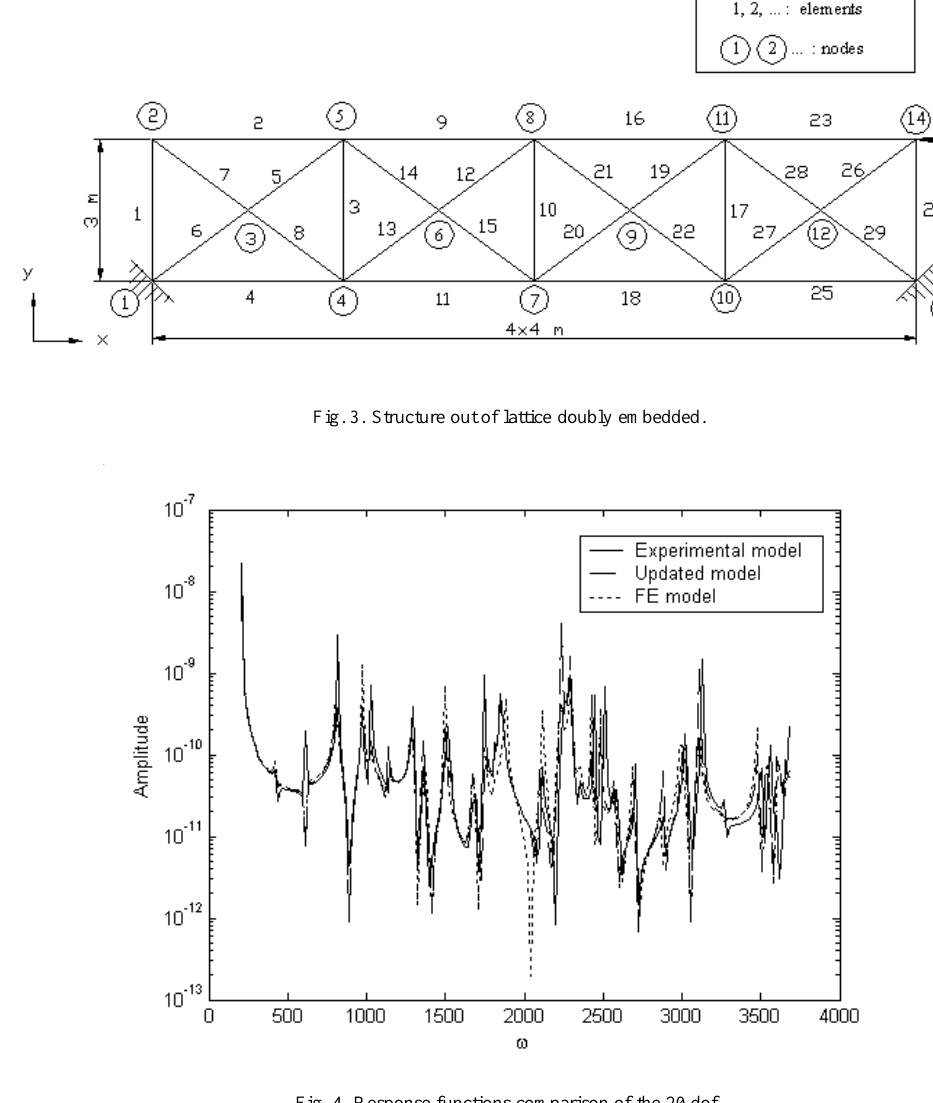
Fig. 4. Response functions comparison of the 20